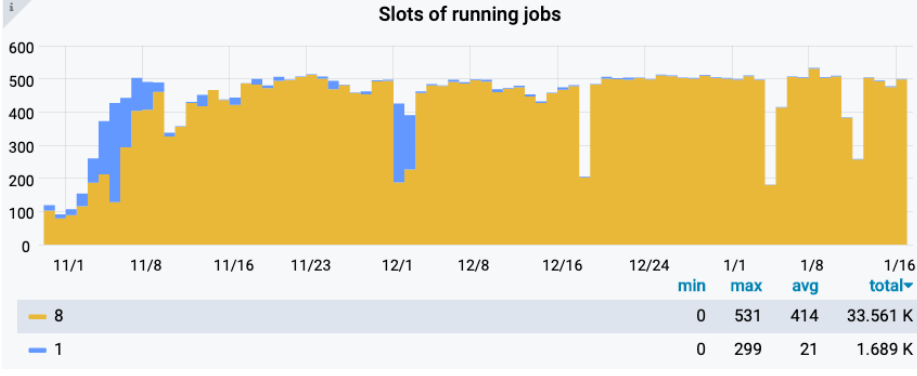
Fig. 5. Stable operations of the 500-core UVic production cluster CA-VICTORIA-K8S-T2. The abrupt brief dips in usage are due to scheduled downtimes for network maintenance external to the